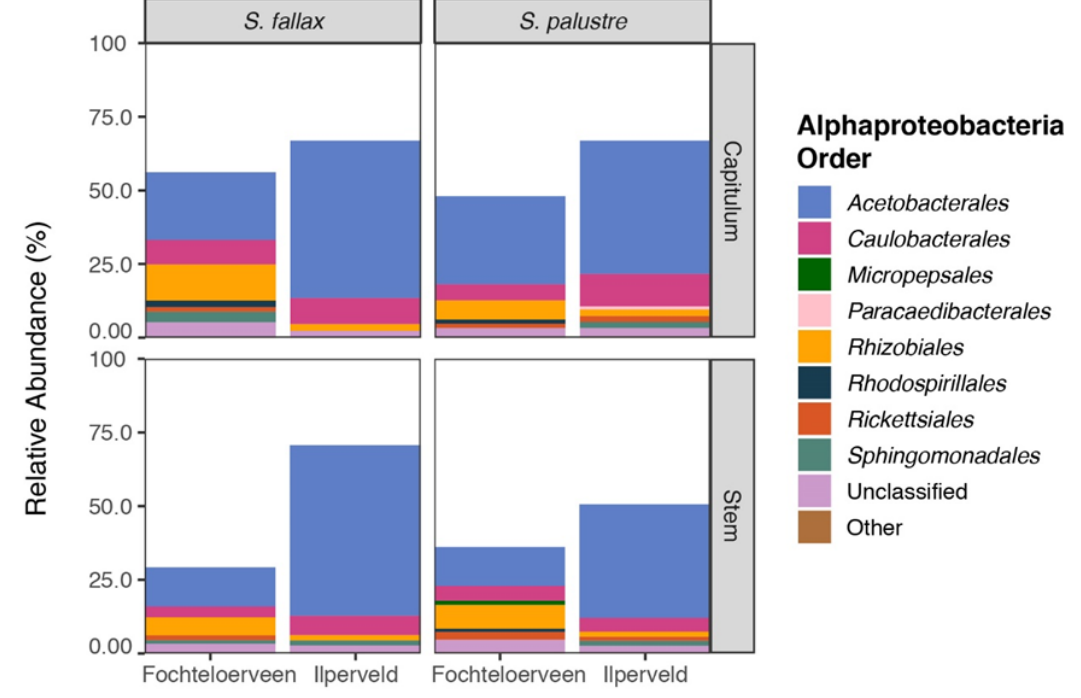
Figure 3. The relative abundance of all phyla (only phyla that make up >1% of the total community are shown) in the microbial community associated with the different Sphagnum segments capitulum (upper 2 panels) and stem (lower 2 panels) from the two Sphagnum species studied; S. fallax (left) and S. palustre (right) in the different sites (FV and IV).